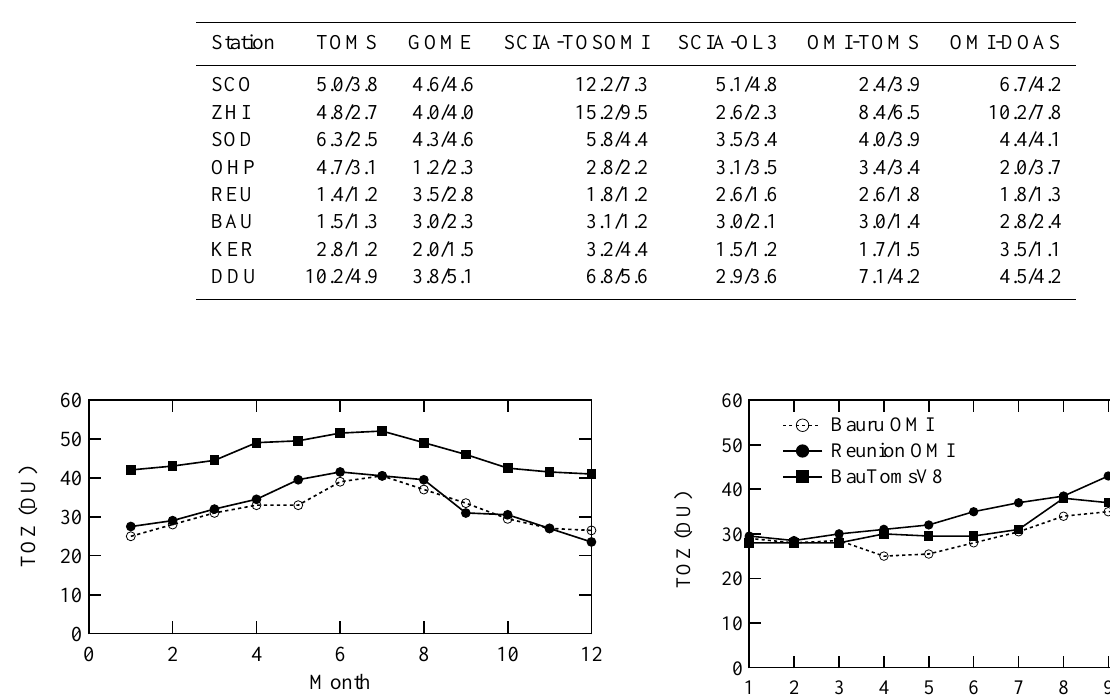
Table 9. Residual amplitude of the satellite-SAOZ V2 difference seasonal cycle (in %) before/after temperature (50hPa) and SZA correction. See Table 5 for the meaning of the abbreviations of the stations.